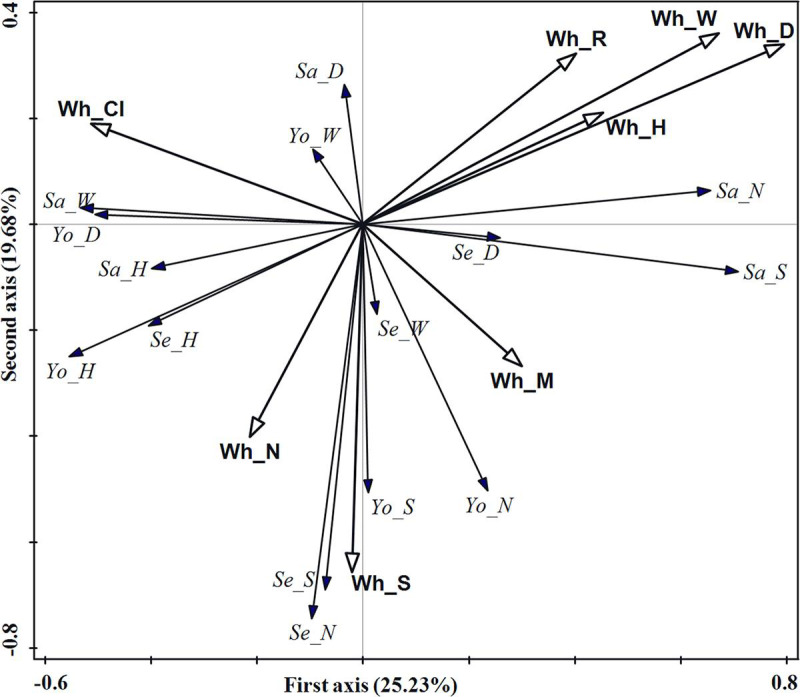
RDA ordination diagram of whole stand structure indices and
regeneration in the evergreen broad-leaved forest.Hollow arrows represent stand structure indices and solid arrows
represent regeneration indicators. Wh_M, Wh_CI, Wh_R, Wh_S, Wh_DBH,
Wh_H, Wh_W and Wh_N denote the mingling index, competition index,
aggregation index, tree species richness index, diameter at breast
height, tree height, crown width and density, respectively. Se_N, Se_D,
Se_H, Se_W and Se_S denote seedling density, basal diameter, tree height
crown width and tree species richness index, respectively; Sa_N, Sa_D,
Sa_H, Sa_W and Sa_S denote sapling density, basal diameter, tree height,
crown width and tree species richness index, respectively; Yo_N, Yo_D,
Yo_H, Yo_W and Yo_S denote young tree density, diameter at breast
height, tree height, crown width and tree species richness index,
respectively.